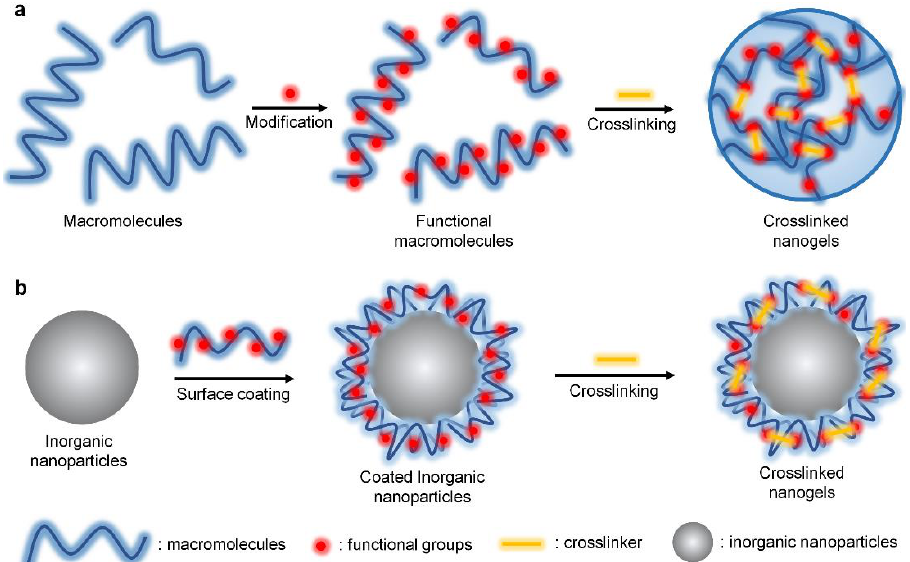
Figure 1. Schematic illustration for preparation of crosslinked nanogels. ( a ) Preparation of macromolecules-based crosslinked nanogels. ( b ) Preparation of inorganic nanoparticles-based crosslinked nanogels.